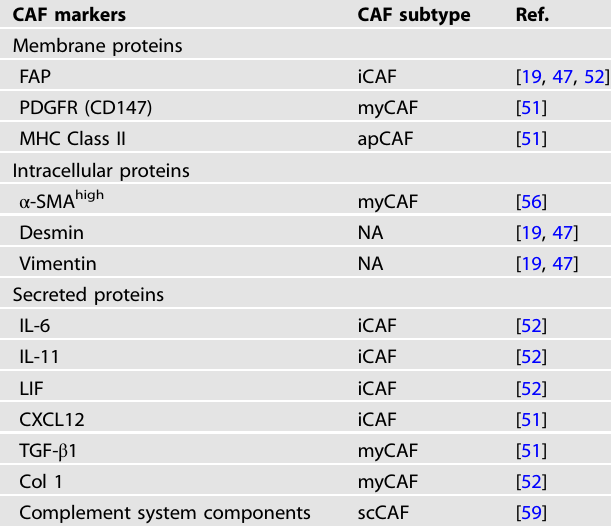
Table 1. Representative markers of different subtypes of CAFs in